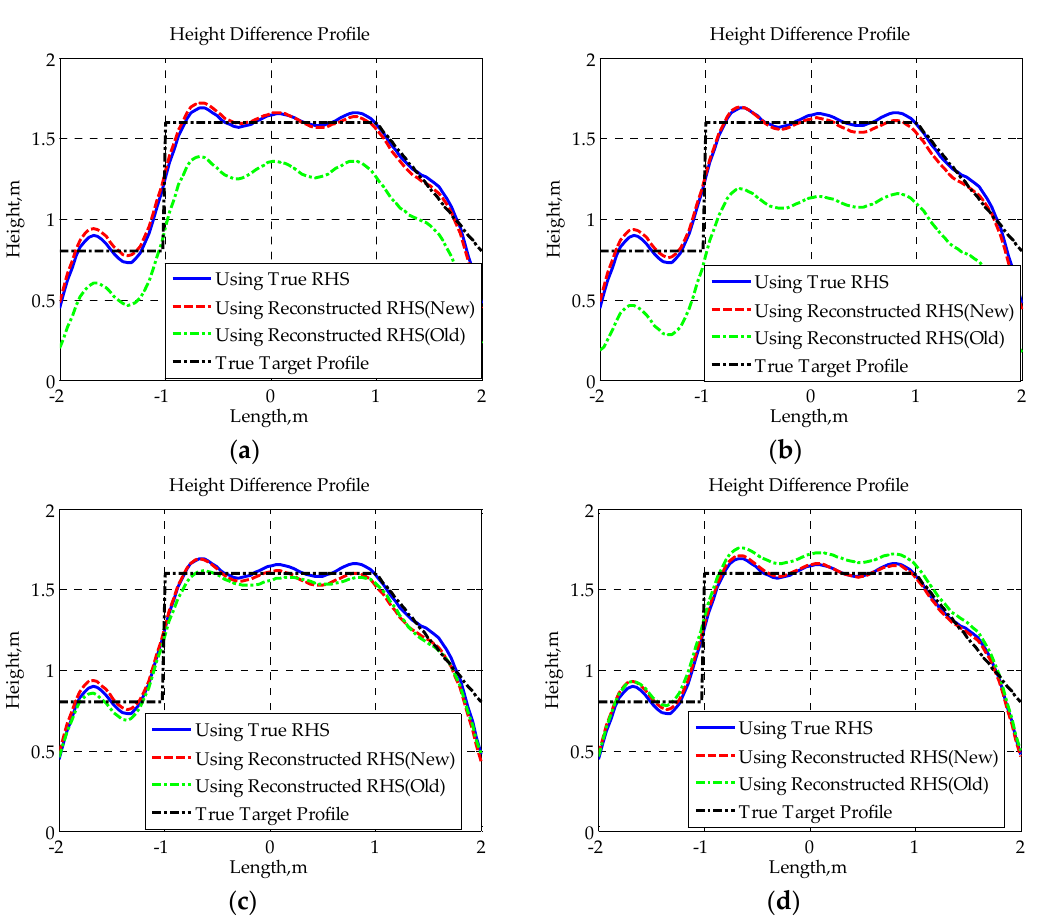
( d ) Figure 16. Median line profiles for baseline lengths: ( a ) 400 m; ( b ) 400.0375 m; ( c ) 400.075 m; ( d ) 400.15 m. From the given results, it can be found that there is not much difference between the shapes of height difference profiles obtained using different RHSs. Though the reconstruction of height difference profile is, to a certain extent, not sensitive to the RHS phase, those distortions in the reconstructed RHS using the traditional method may cause some loss of signal energy (as shown in Figure 15a,b), which will affect the extraction of the true target height. Furthermore, owing to the sensitivity of the median line profile to signal phase, the median line profile seriously deviates from the true profile when the traditional method is applied to reconstruct RHS. However, since the proposed method provides a much higher accuracy in RHS reconstruction, the median line profiles